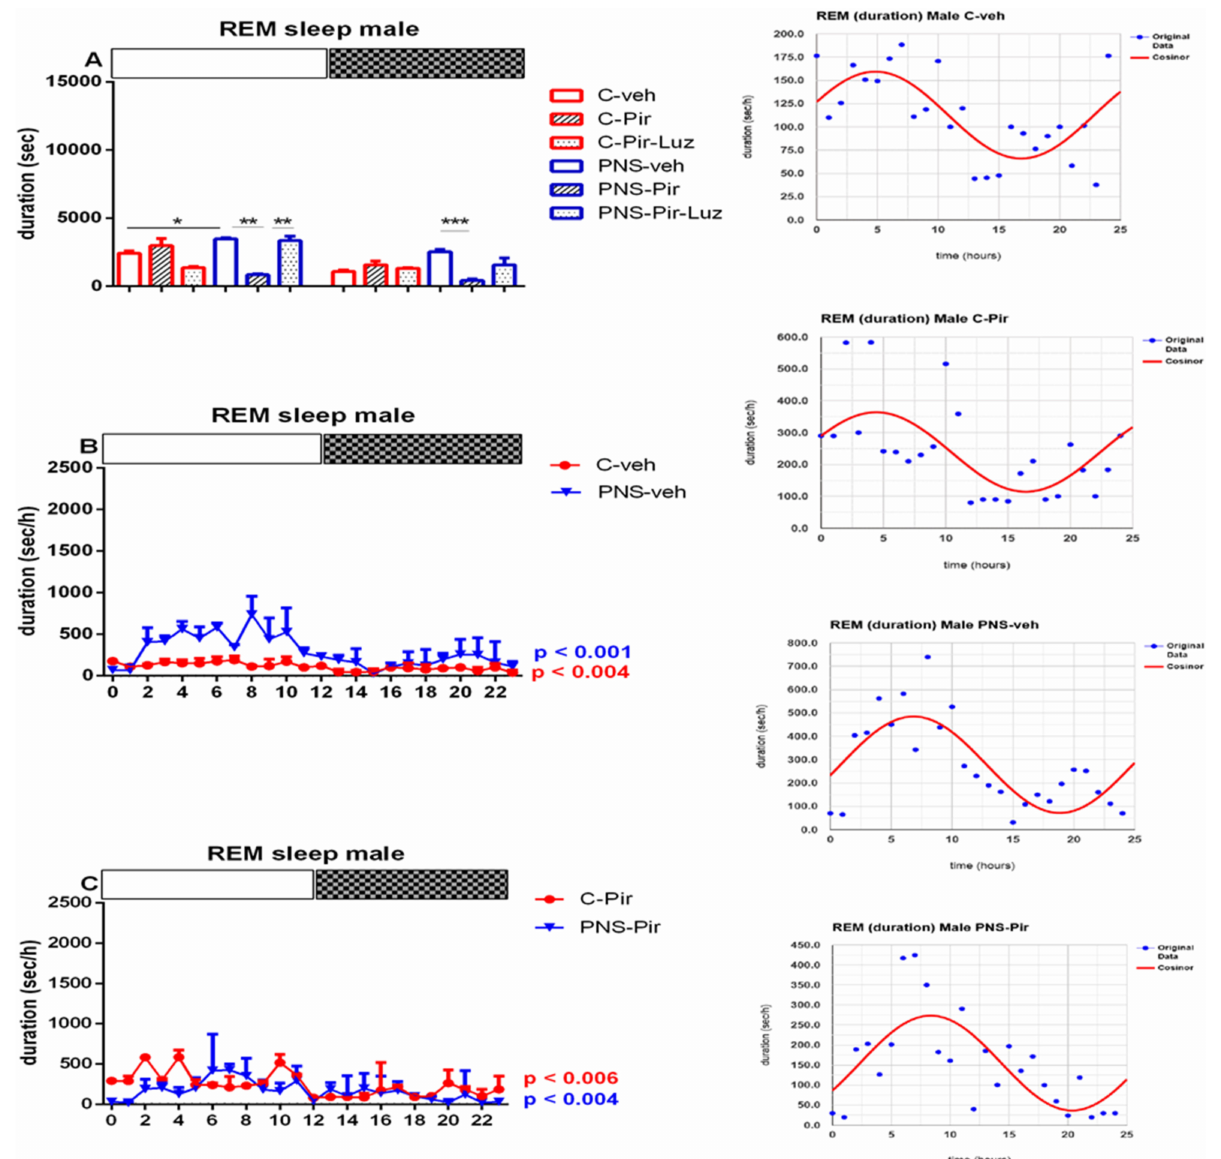
Figure 11. Diurnal rhythm of REM duration (sec/h) in male rats during the Light and the Dark phase, indicated by open and black rectangles above the figure, over a 24-h recording for C-veh, C-Pir, C-Pir-Luz, PNS-veh, PNS-Pir and PNS-Pir-Luz group ( A ). Circadian distribution of REM sleep events (duration, sec/h) for C-veh and PNS-veh groups ( B ) and C-Pir and PNS-Pir group ( C ) over a 24-h recording. Original and cosinor data are shown in the inset on the right. * p < 0.05, ** p < 0.01, *** p < 0.001 vs. C-veh, PNS-veh or PNS-Pir group,